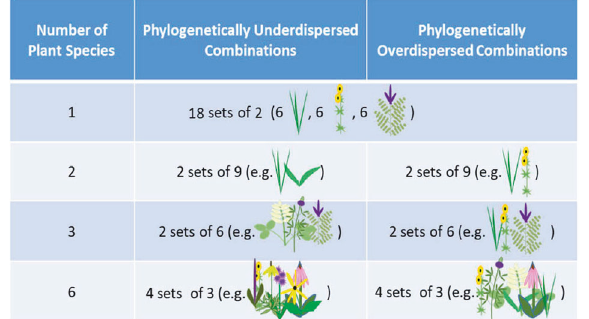
Fig. 1 A factorial description of plot design. Number of plant species denotes the plant species richness treatments (monoculture, 2, 3, or 6 species). Phylogenetically under-dispersed combinations of plants are all within one plant family (e.g. 2 grasses, or 3 legumes, or 6 asters). Phylogenetically over-dispersed combinations of plants are from more than one plant family (e.g. 1 grass and 1 aster, or 1 species from each family, or 2 species from each family). Monocultures are inherently under-dispersed. The sets